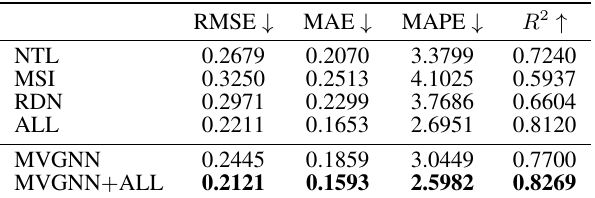
Table 1. Results of different input features using RF regressor. ( ALL=NTL+MSI+RDN , MVGNN refers to the embeddings learned from the MVGNN model with input features of ALL ) RMSE ↓